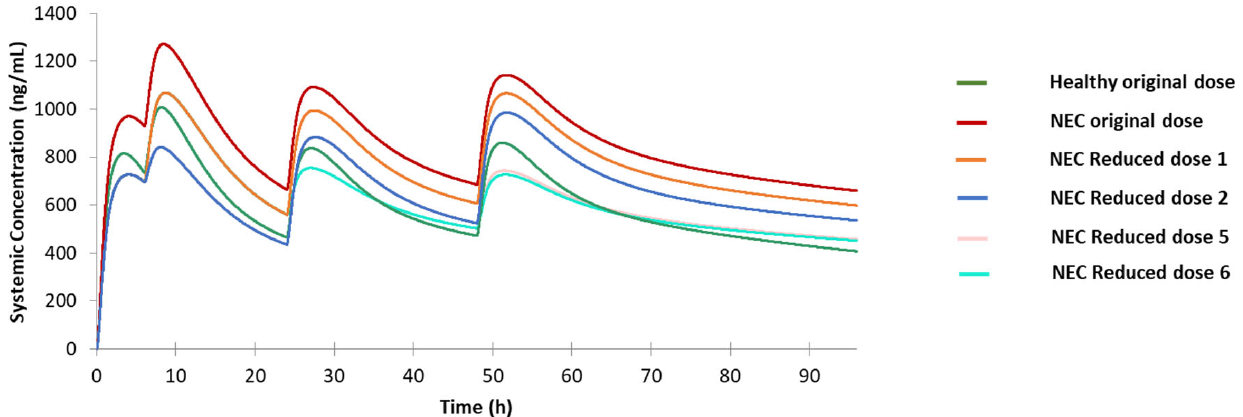
Figure 7. Predicted drug concentration for the healthy population under original dose, the geriatric Northern European Caucasians (NEC) population under original dose, and NEC population under Reduced dose 1, 2, 5, and 6.